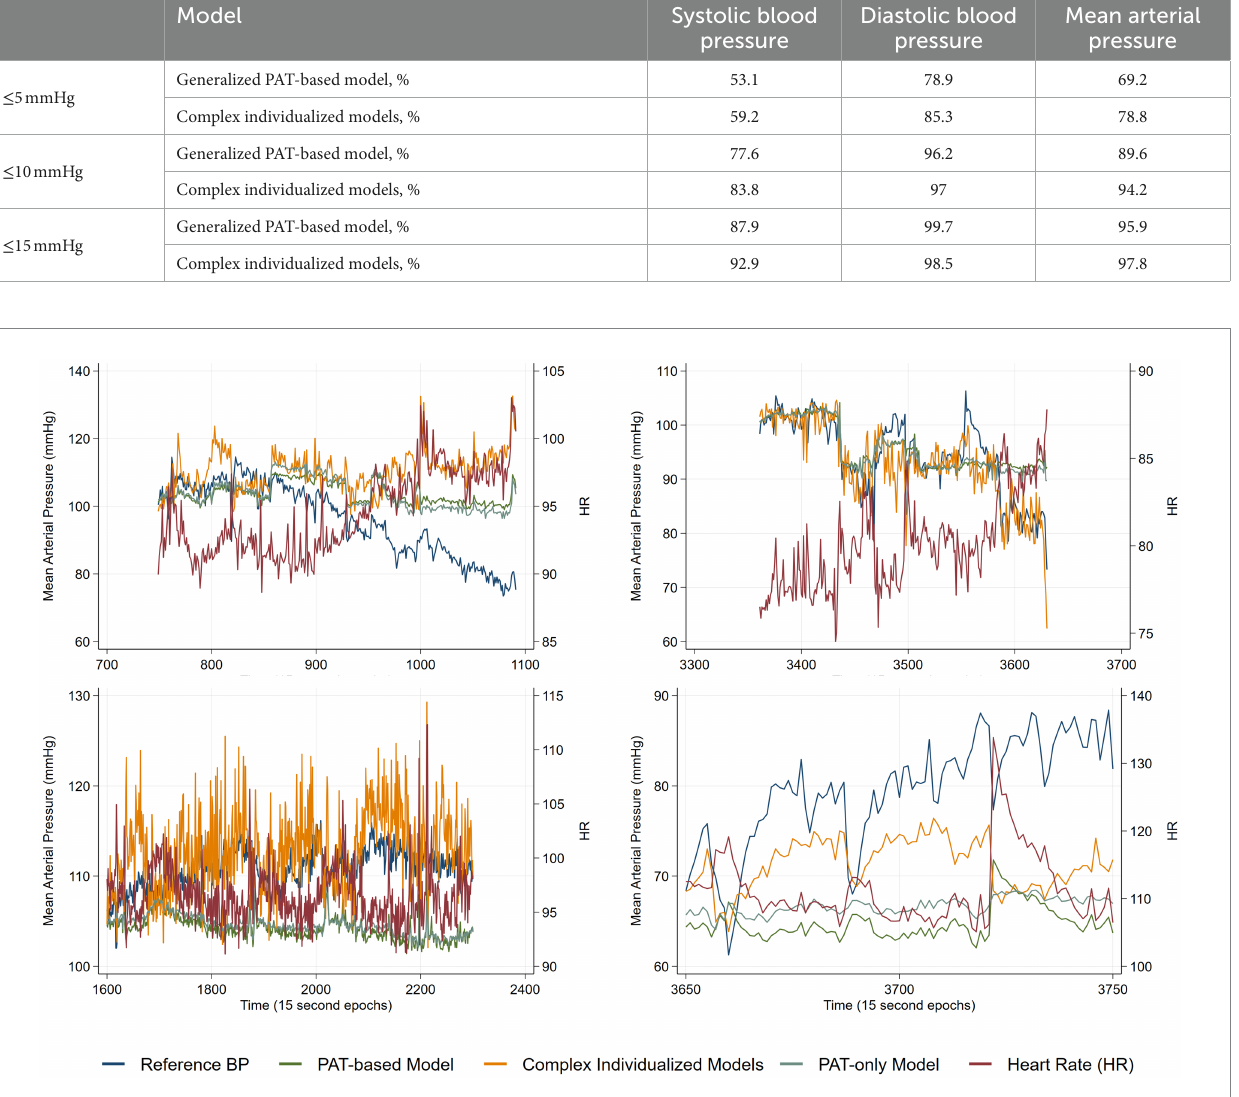
everyday management of patients in the ICU, brachial oscillometric cuff BPs are taken regularly. Our LOA were considerably narrower compared to SBP LOA of [ − 30.2, 31.7 mmHg] revealed in a